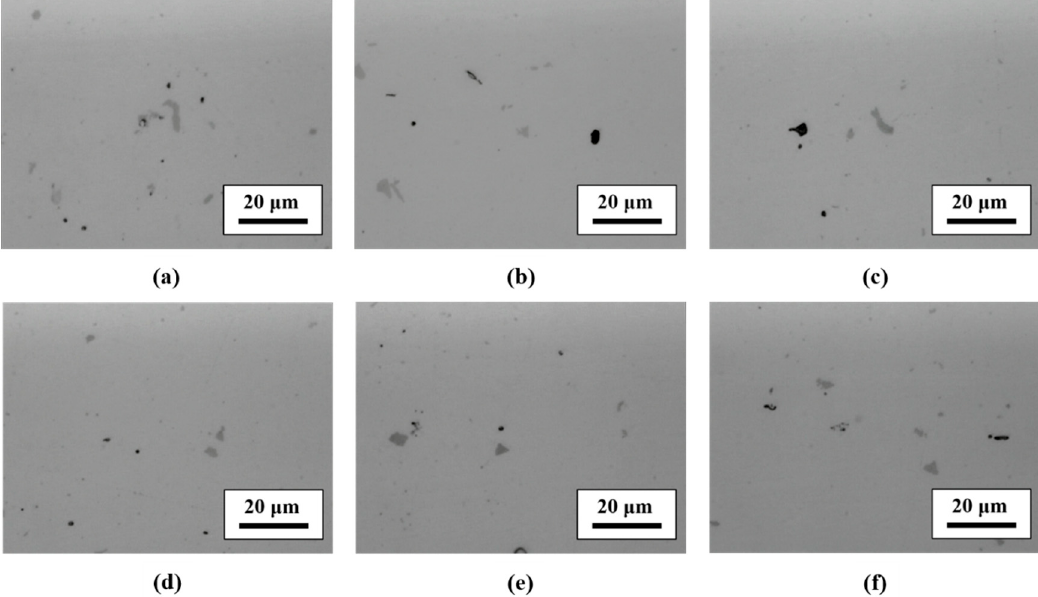
Figure 4. Microstructure observation results of specimens (forging A: ( a – c ), forging B: ( d – f )). ( a ) As-received A, ( b ) RA120, ( c ) IA120, ( d ) as-received B, ( e ) RB120, and ( f ) IB120.